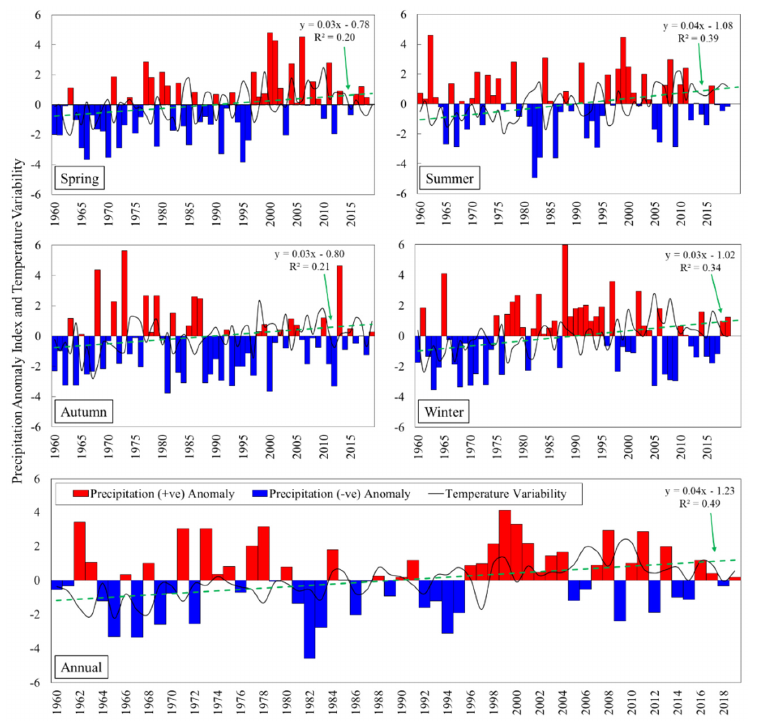
Figure 7. Long term precipitation anomaly index and temperature variability of Gurudongmar region in Sikkim Himalaya during 1960 −